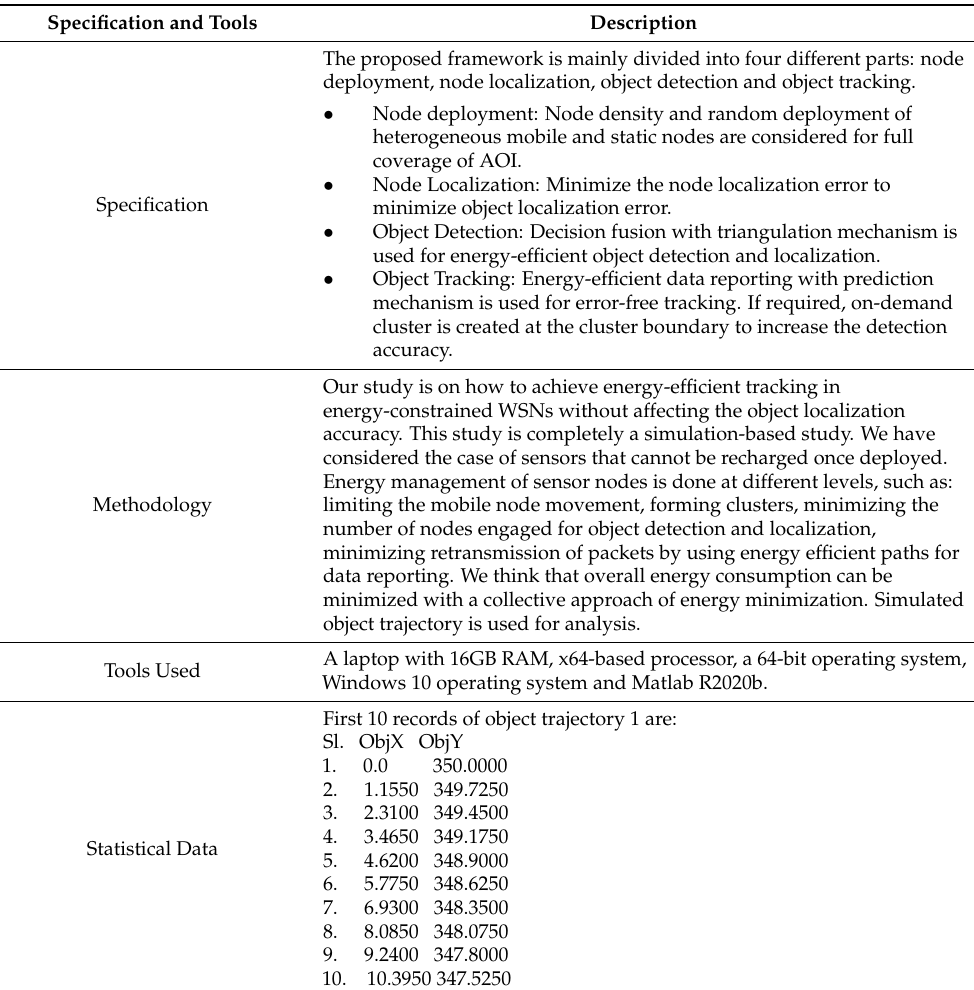
Table 14. Summary of Proposed